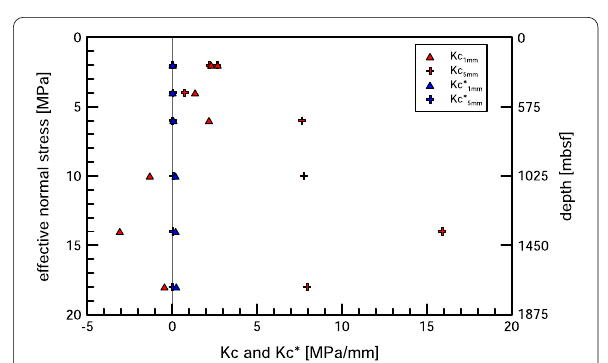
Fig. 6 Critical stiffness results. Velocity- and slip-dependent critical stiffnesses Kc and Kc* as a function of effective normal stress. Depth calculation is based on shipboard moisture and density measurements, assuming hydrostatic pore water